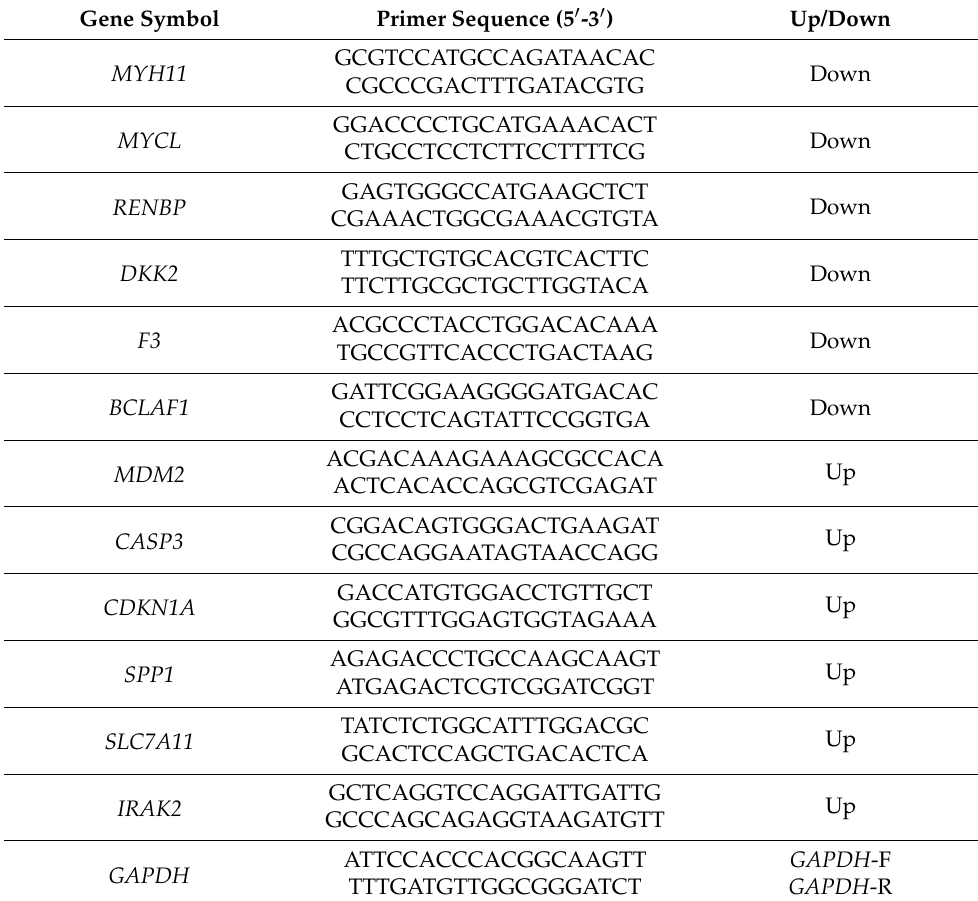
Table 2. Primer sequences used in qPCR experiments.